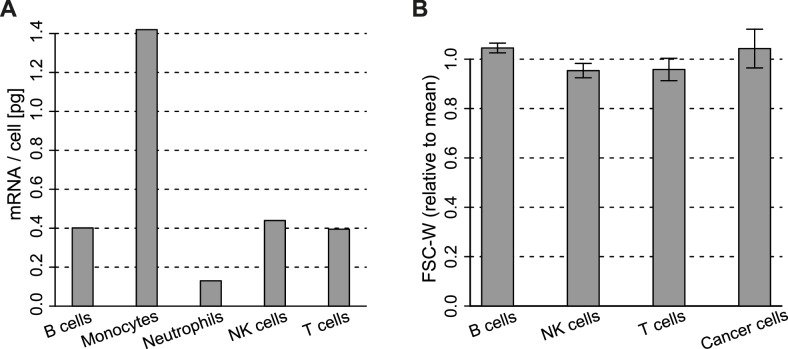
Cell type mRNA content.(A) mRNA content per cell type obtained for cell types sorted from blood. Values for B, NK, T cells and monocytes were obtained as described in Materials and methods. Values for Neutrophils are from Subrahmanyam et al. (2001). (B) Width of the forward scatter values for the different immune and cancer cells from flow cytometry data of melanoma metastatic lymph nodes. Data were first normalized by the mean FSC-W for each donor. Error bars represent the standard deviation from data of 4 patients.